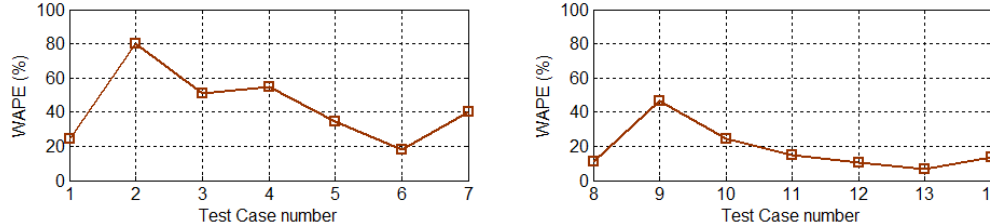
Figure 11. Weighted absolute percentage error ( WAPE ) calculated for the fourteen test cases using the neural network Model